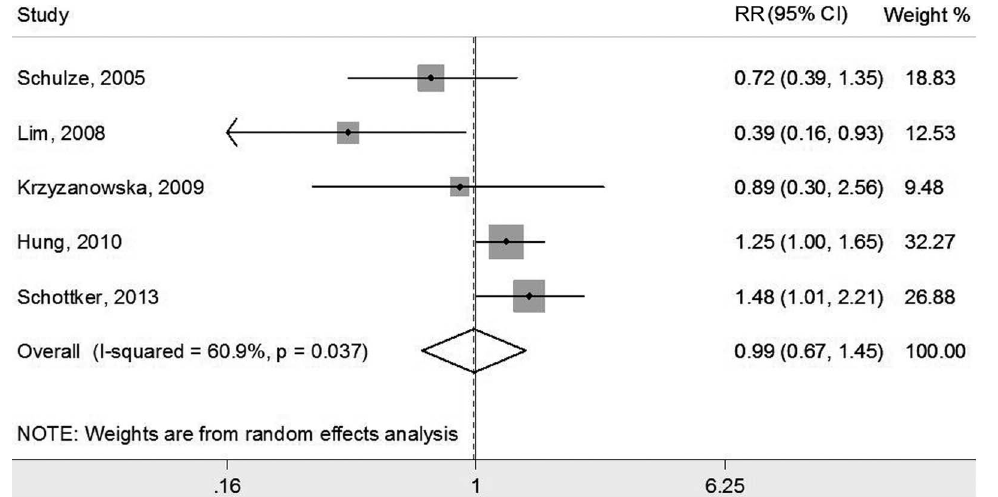
Figure 2. Forest plot showing meta-analysis on the association between adiponectin concentrations and risk of cardiovascular diseases in diabetics.